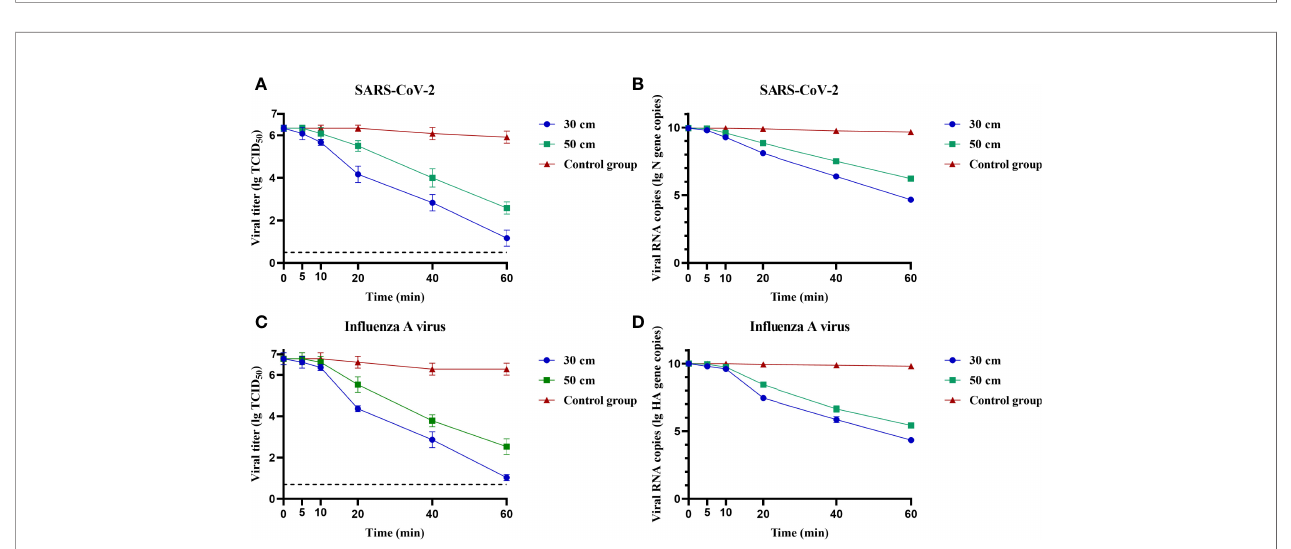
FIGURE 2 | Fixed virus disinfection effect by negative ions. The disinfection effect of negative ions on fi xed severe acute respiratory syndrome coronavirus 2 (SARS- CoV-2) (A, B) and in fl uenza A virus (C, D) was analyzed at different time points and different heights. Both viral titer and RNA copies were determined. Dashed lines indicate the lower limit of virus detection. The bar means: Mean ±